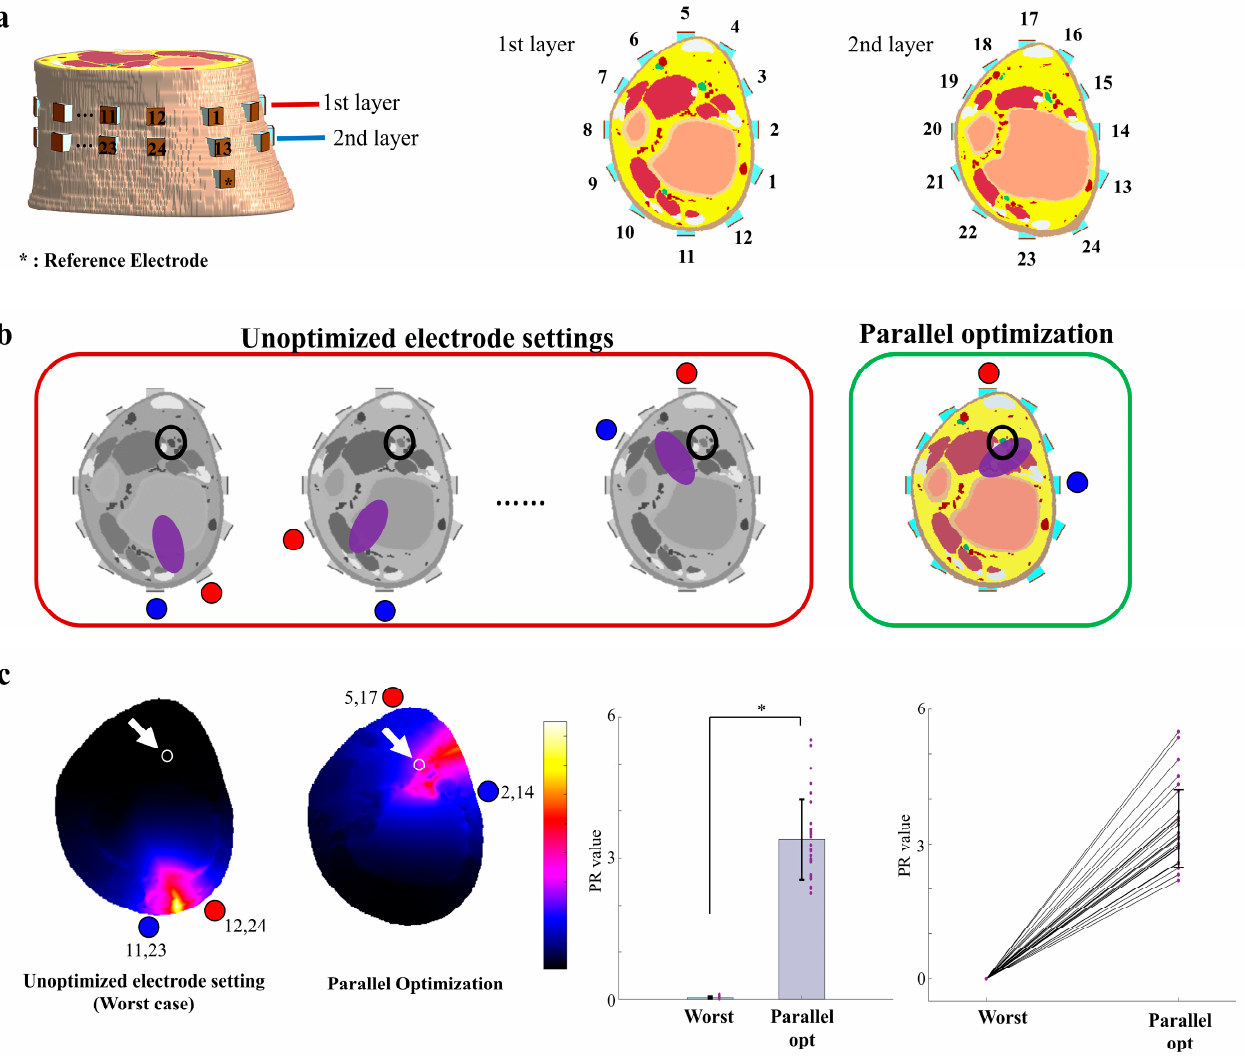
Figure 3. Comparison of TI stimulation results in the worst case and parallel electrode pair opti- mization. ( a ) Example of an electrode arrangement for TI stimulation ( b ) Concept of an unoptimized electrode setting and optimized electrode setting. ( c ) Comparison of worst TI and parallel opt TI results, * p < 0.001.